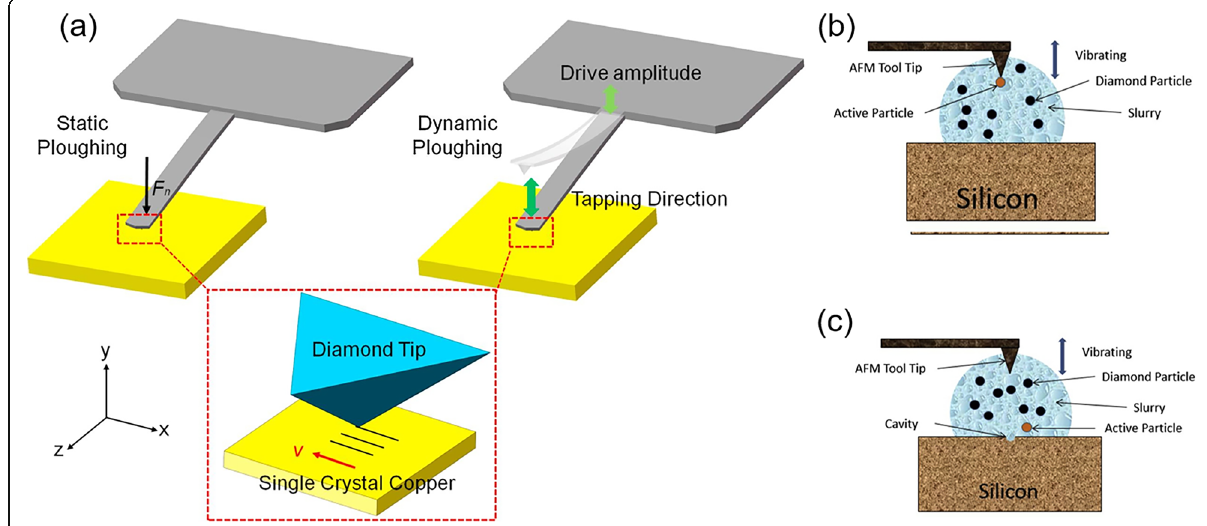
Fig. 2 a The schematics of the static and dynamic ploughing lithography on single crystal copper [19]. b AFM tool tip striking a diamond particle. c diamond particle striking the workpiece